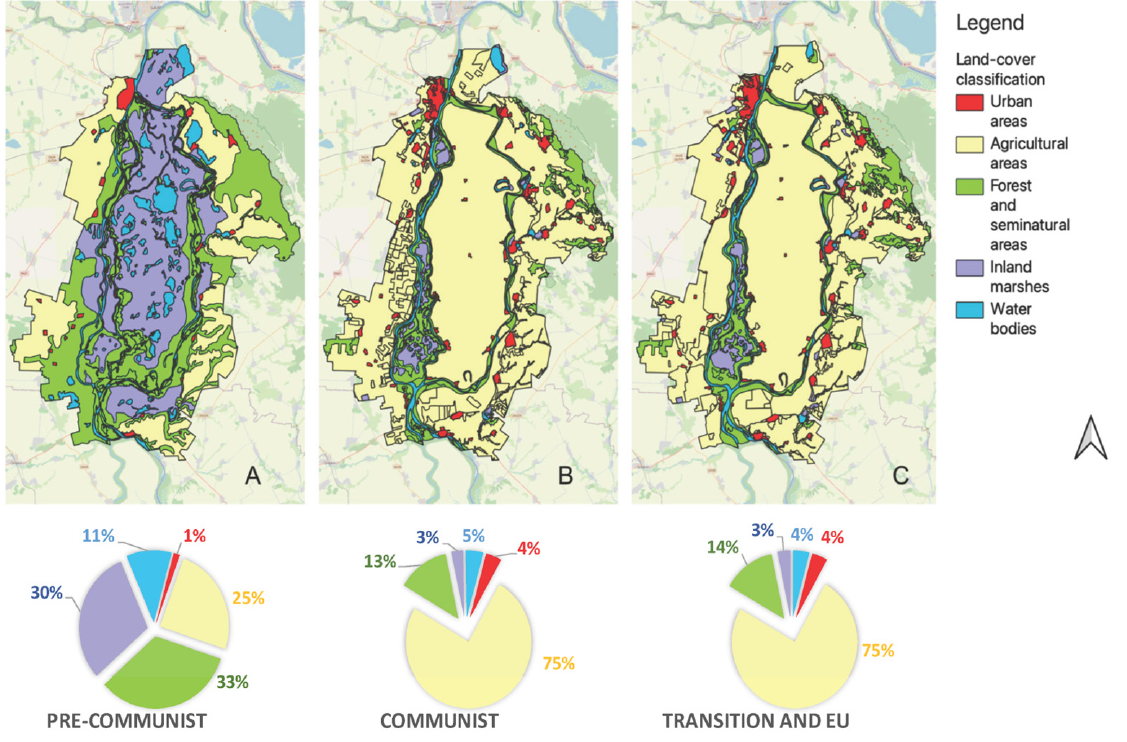
Figure 3. Land cover distribution dynamics in the Br ă ila Island case study area for the pre-communist ( A ), communist ( B ), and transitional and EU periods ( C ).